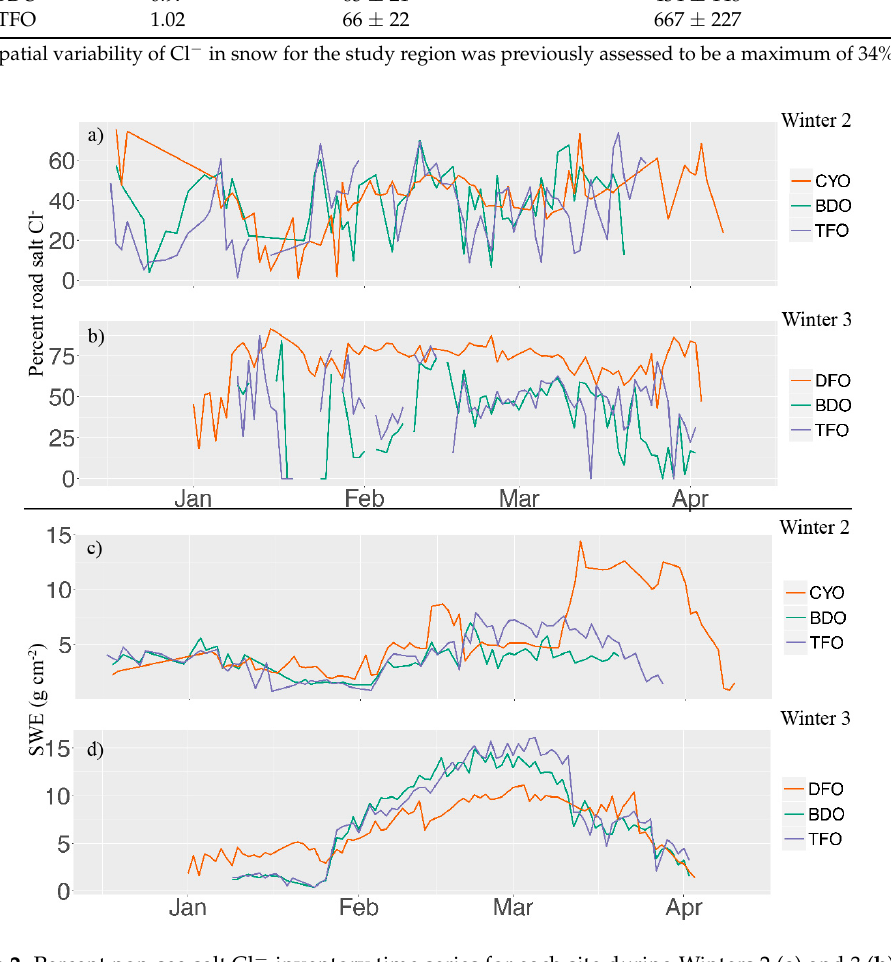
Figure 2. Percent non-sea salt Cl − inventory time series for each site during Winters 2 ( a ) and 3 ( b ) and total SWE for Winters 2 ( c ) and 3 ( d ). Percent Cl − are the percent of the total daily pit Cl − inventory that is calculated to be due to road salt. Percent Cl − data gaps are days when no snow chemistry data was gathered either due to no snow or severe weather. The SWE data has been interpolated over missing data points. The Hanover site moved to DFO from the CRREL Yard (CYO) between Winters 2 and 3; DFO is more than 150 m closer to a maintained roadway than CYO.